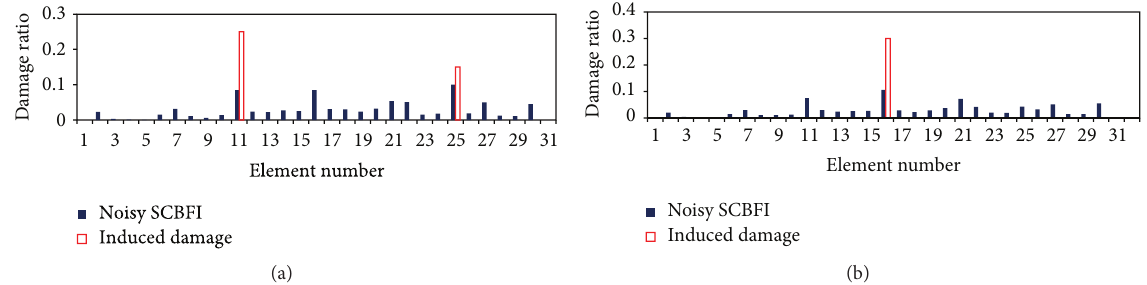
Figure 14: The SCBFI for 31-bar truss considering 2% noise for (a) case 1 and (b) case 2.